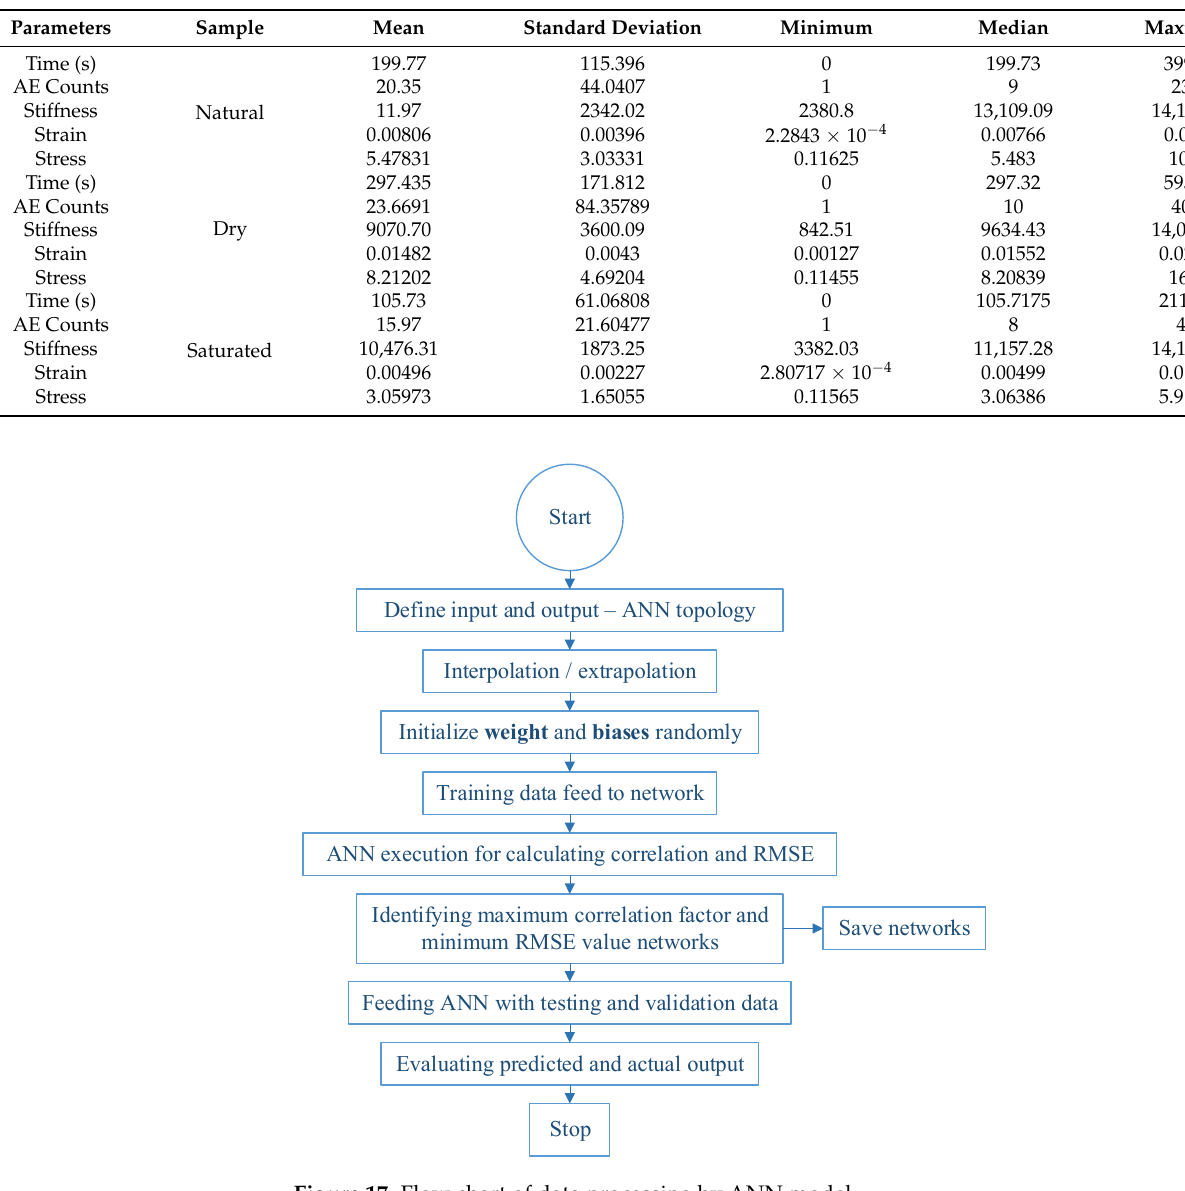
Figure 16. The effect of water on stress in different stages of dry, natural, and saturated coal sample.